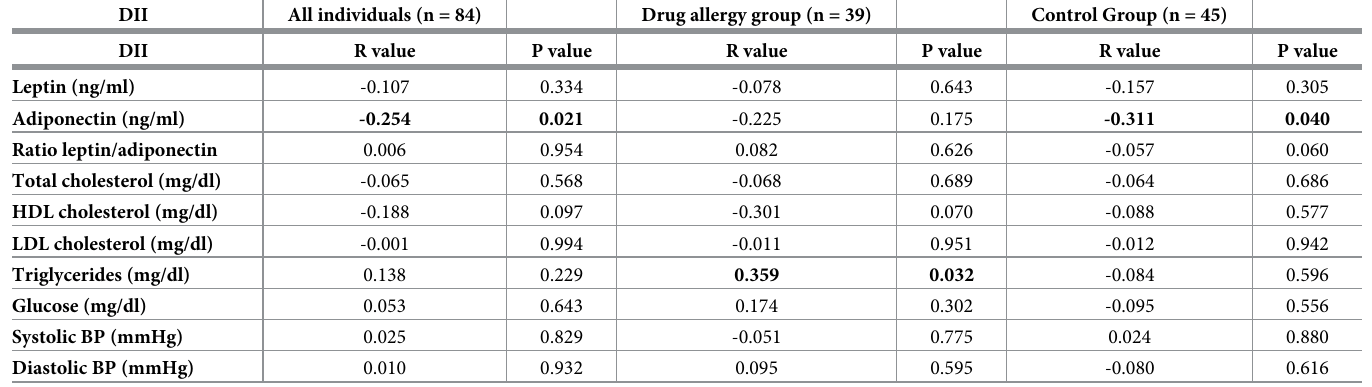
Table 3. Correlations between DII and adipokines levels, biochemical parameters and other parameters.